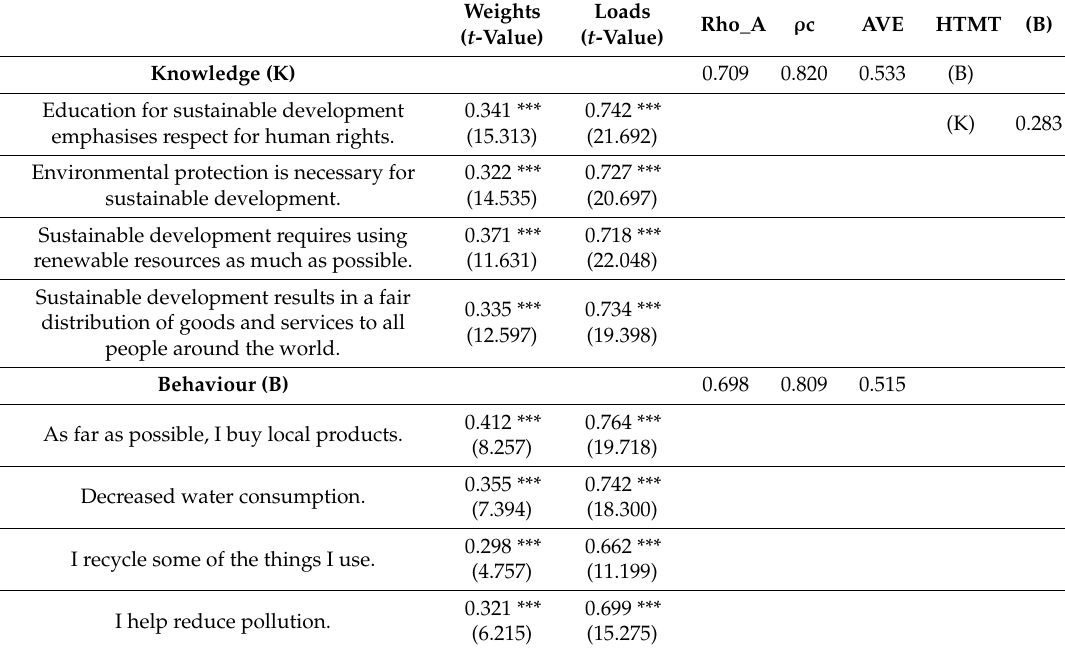
Table 2. Validity and reliability of the measurement model. Composite Mode